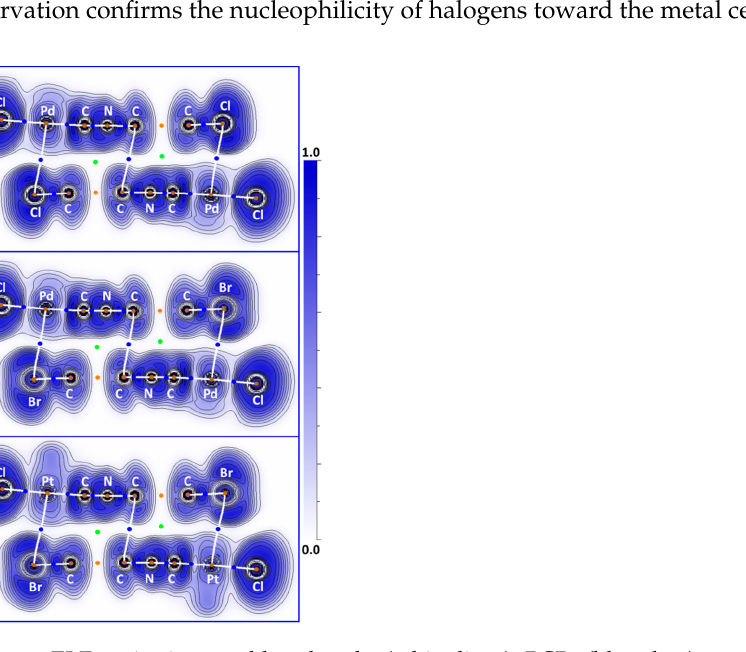
Figure 8. ELF projections and bond paths (white lines), BCPs (blue dots), nuclear critical points (brown dots), ring critical points (orange dots), and cell critical points (green dots) for the M ∙∙∙ X and C ∙∙∙ C’ interactions in the ( 1 ) 2 (left), ( 2 ) 2 (middle), and ( 3 ) 2 (right) dimeric clusters of type II. Similar conclusions can be withdrawn from the inspection of 1D profiles of electron density and electrostatic potential along the bond paths (Figure 9), where ED minima are closer to metal nuclei.